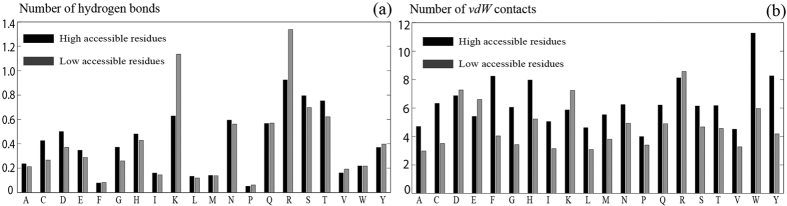
Average number of hydrogen bonds (a) and vdW contacts (b) formed between a ligand and a low-accessibility or a high-accessibility residue.